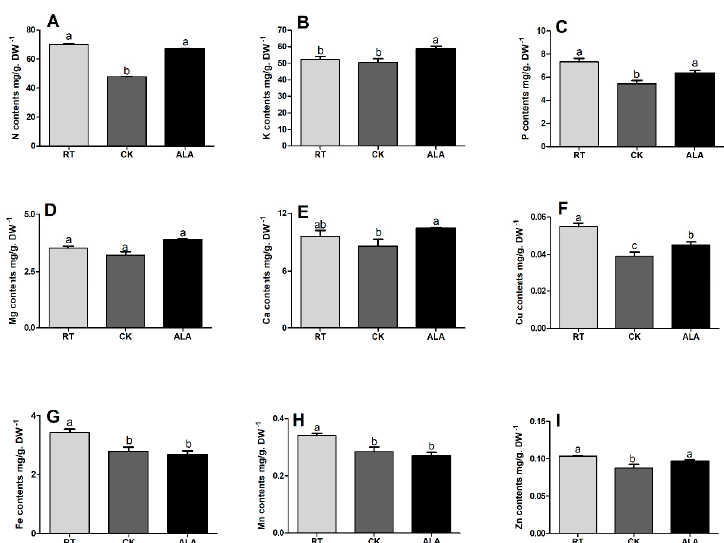
Figure 5. Effect of ALA on root nutrient contents ( A ; Nitrogen, B ; Potassium, C ; Phosphorus, D ; Magnesium, E ; Calcium, F ; Copper, G ; Iron, H ; Manganese, and I ; Zinc) under low-temperature stress. RT = regular temperature; CK = control; ALA = 30 mg/L ALA. Different letters indicate a significant difference at p < 0.05. Int. J. Mol. Sci. 2018 , 19 , x In addition, ALA also increases leaf nutrient content of N, K, P, Mg, Mn, Cu, Fe, Ca, and Zn compared to the CK treatment by 12.49%, 4.84%, 31.15%, 35.35%, 34.13%, 22.27%, 35.10%, 37.51%, and 27.17%, respectively (Figure 6). To compared with RT, the N, K, P, Mg, Mn, Cu, Fe, Ca and Zn of